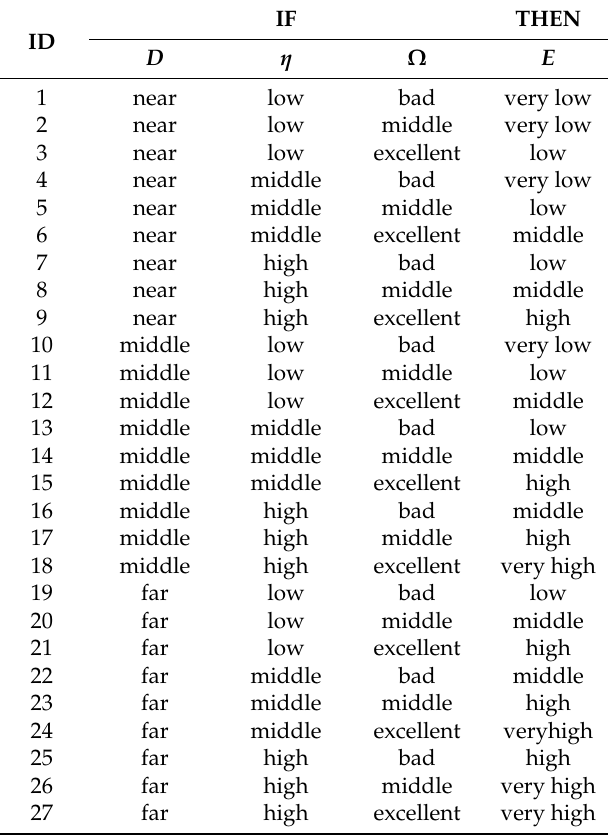
Table A1. Fuzzy reasoning rule